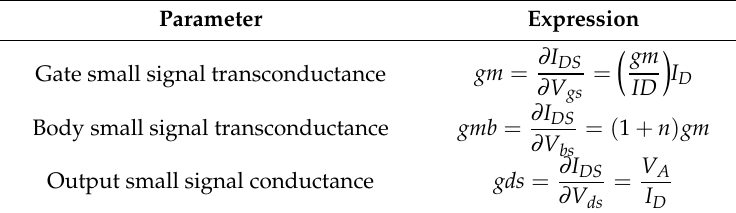
Table 3. MOS transconductance and conductance expressions.